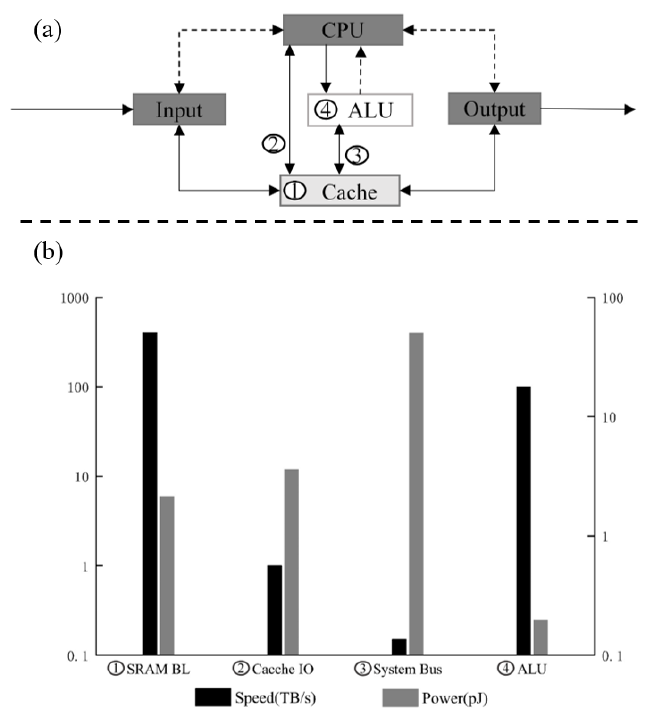
Figure 1. ( a ) Von Neuman architecture; ( b ) performance statistics for each module in the von Neu- mann